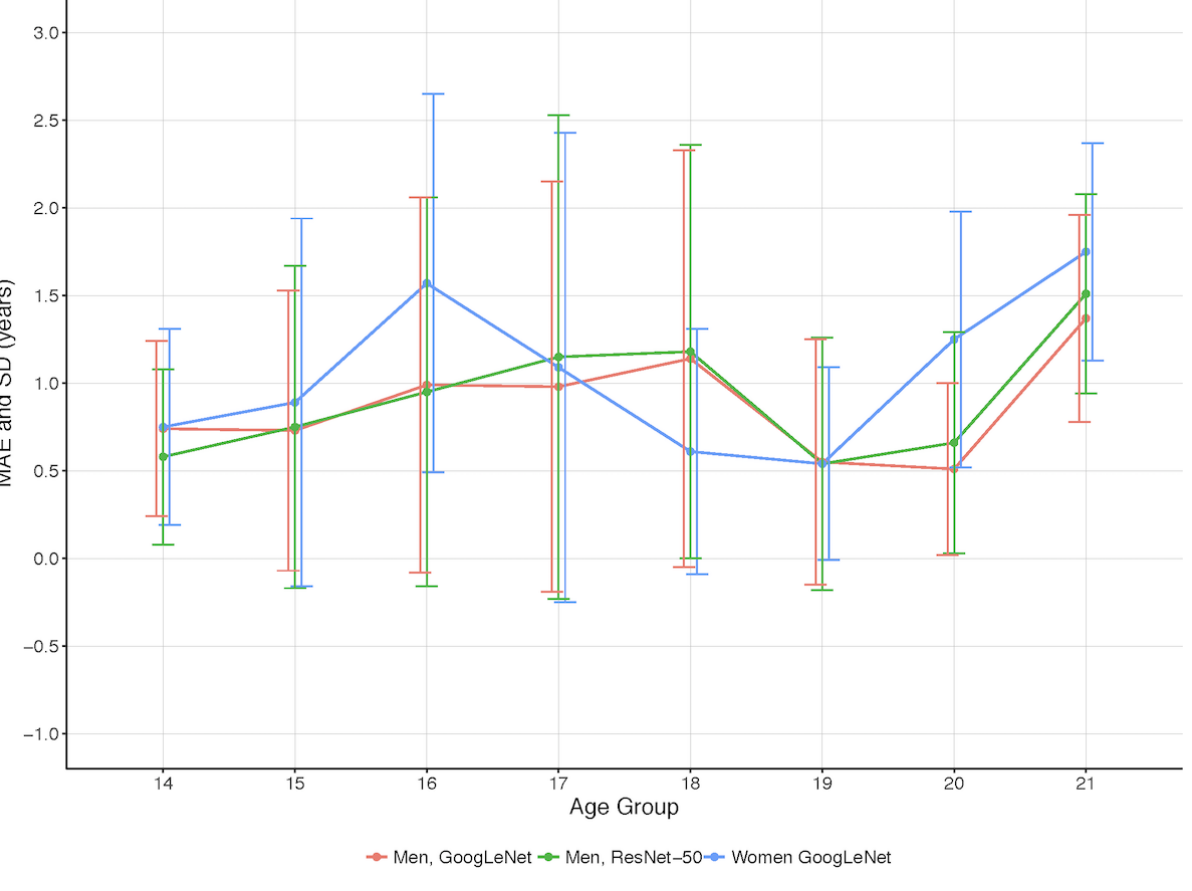
Figure 5. Comparison of the best-performing models: GoogLeNet and ResNet-50. MAE: mean absolute error.